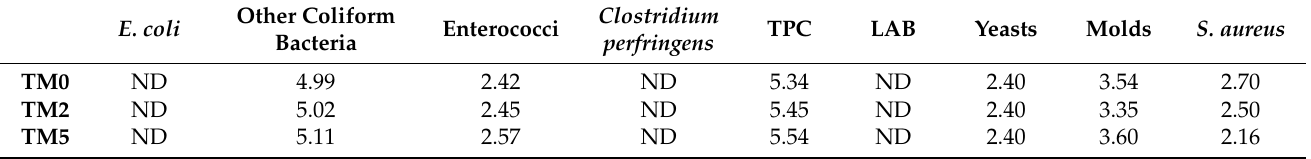
Table 7. Feed microbial analysis at the end of the storage period (log